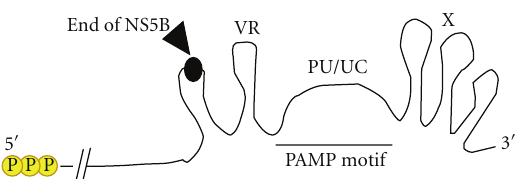
Figure 3: Domains of the HCV genome featuring the 3 (cid:2) NTR. Details are described in the text. 5 (cid:2) ppp and the poly-U/UC region of the HCV genome or the genome replication intermediate RNA are the major PAMP determinants of HCV that are recognized by RIG-I. Arrow head marks the end of the HCV protein-coding region. The PAMP motif is